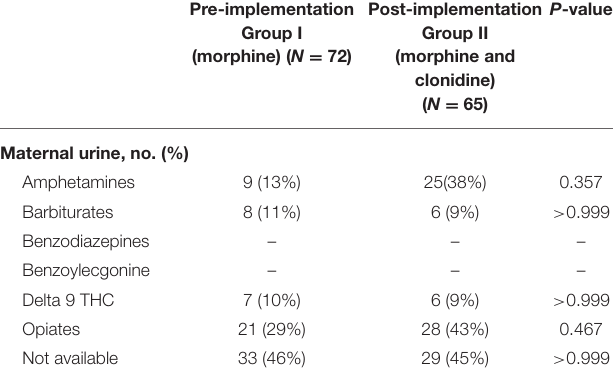
TABLE 3 | Maternal urine toxicology profile.